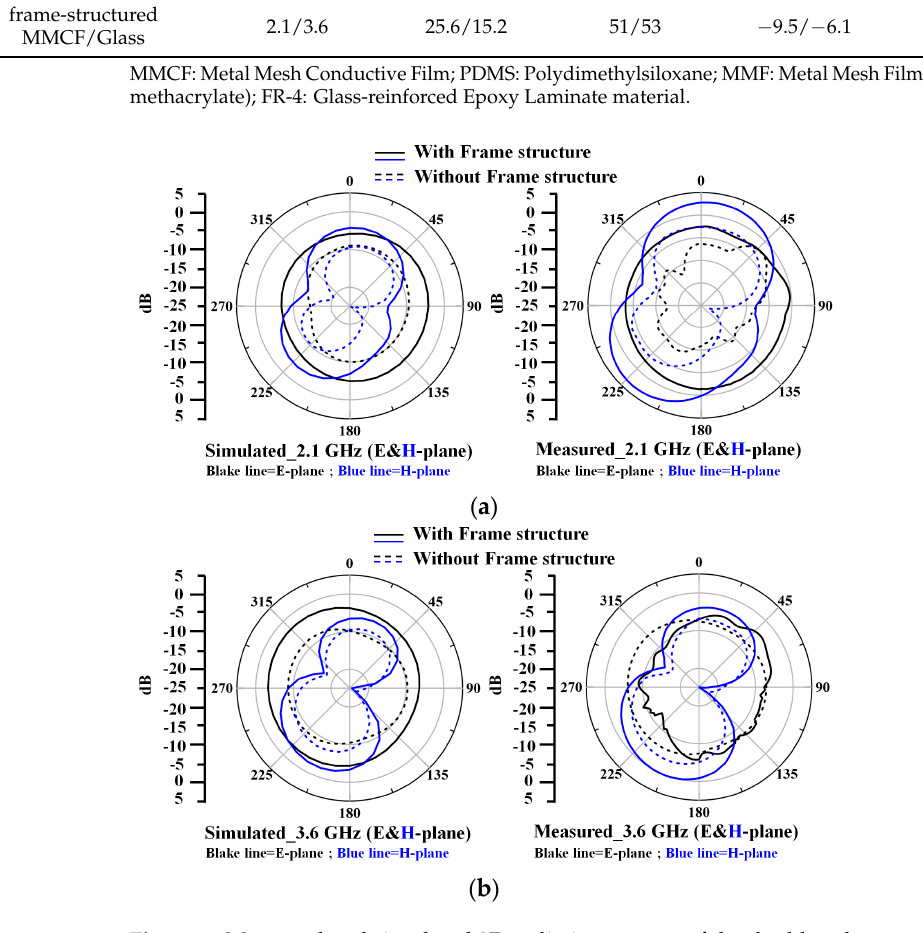
Figure 9. Measured and simulated 2D radiation pattern of the dual-band transparent antenna ( a ) at 2.1 GHz and ( b ) at 3.6 GHz using the frame structure (solid line) and without using the frame structure (dash line). Table 1. Performance comparison of this study with other previous transparent antenna refer- ences.